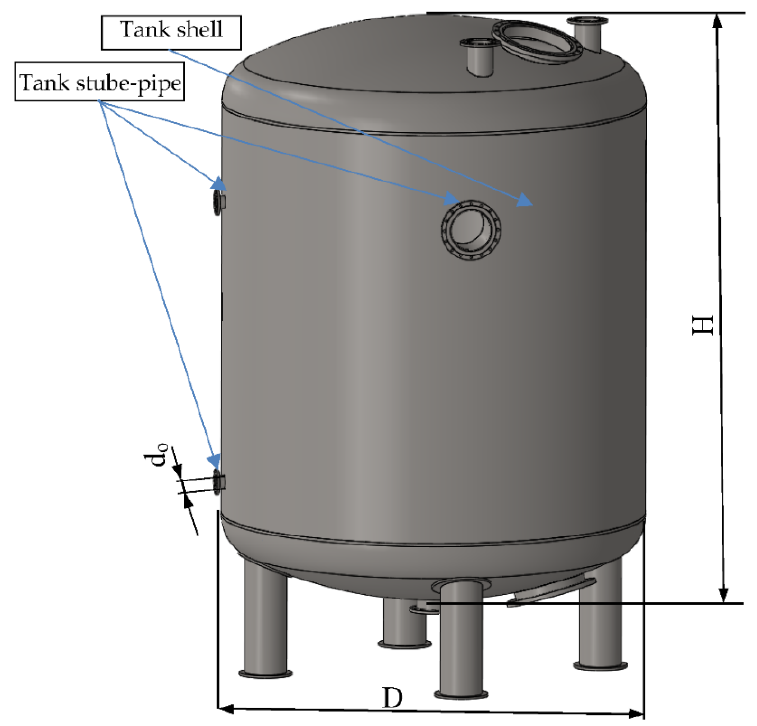
Figure 1. An example of a thin-walled tank for a liquid with stub-pipes.